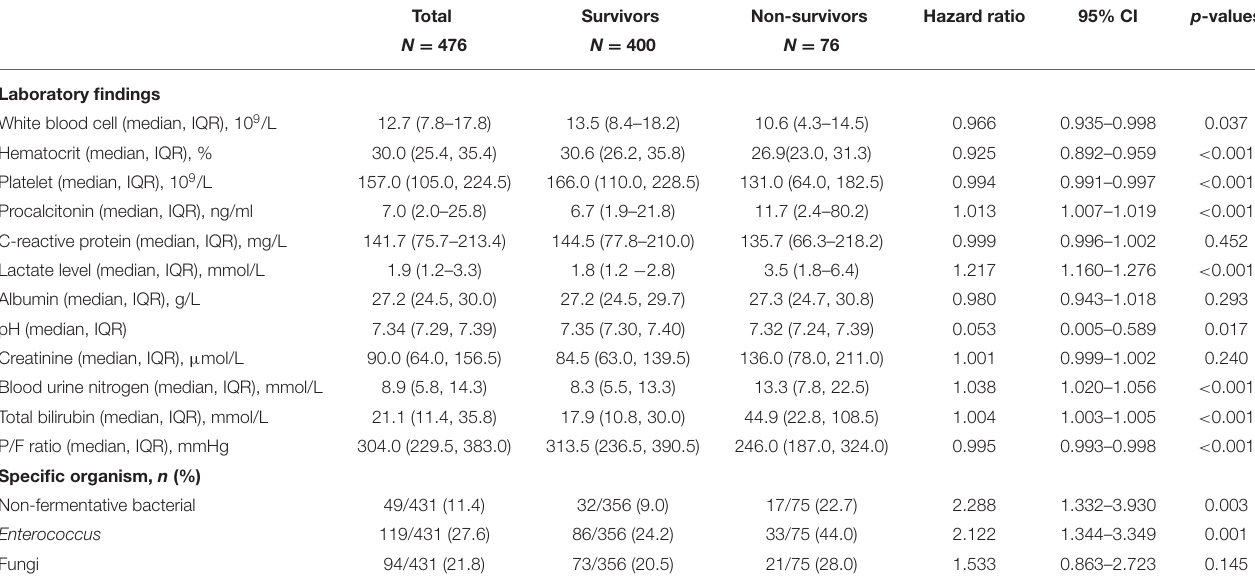
TABLE 2 | Laboratory findings and organism distribution of ICU-IAIs